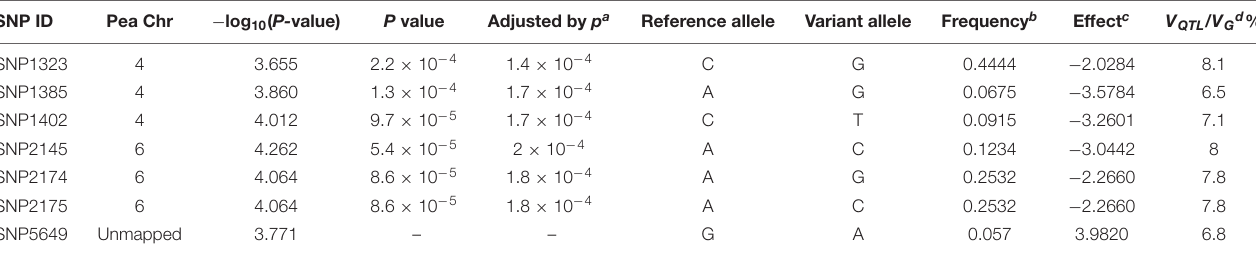
TABLE 1 | List of single-nucleotide polymorphism (SNP) markers significantly associated [ − log 10 ( P- value) = 3.5] with grass pea response to Uromyces pisi infection. SNP